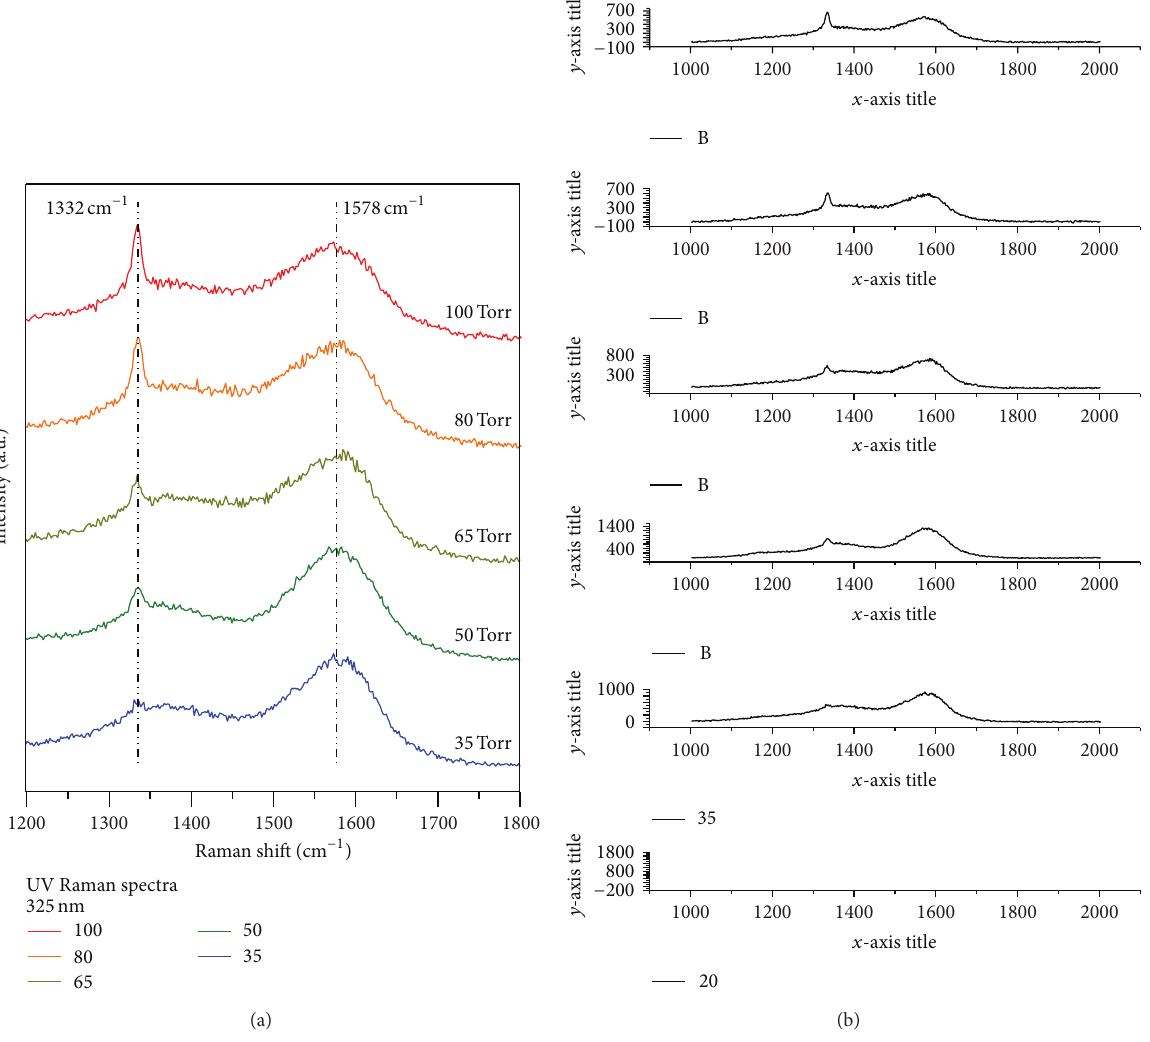
Figure 4: The Raman spectra of the as-prepared diamond films deposited under working pressure ranged from 35 Torr to 100